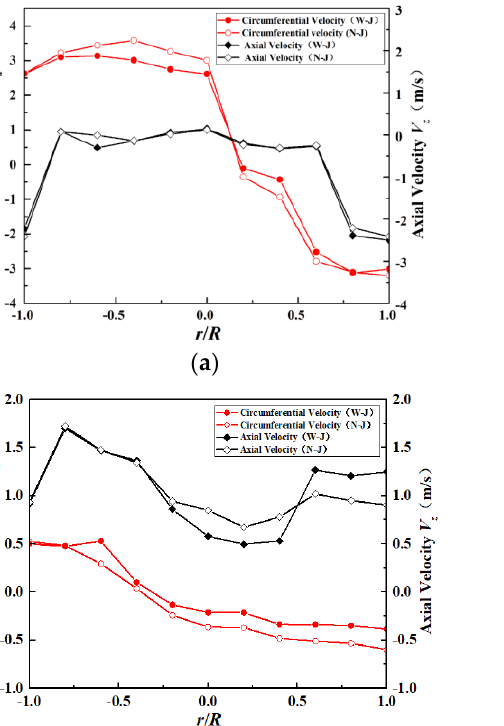
10 of 20 Figure 8. LEPR on section 2 of the draft tube at DPL and PL conditions with or without J-groove. 4.2. Influence of J-Grooves on Velocity Distribution At partial loads, the water no longer flows along the so- called “structural line” of the runner after entering the runner, but rapidly deflects downward the band under the cen- trifugal force [27]. As a result, the rotating speed of the water flow in the runner blade channel increases, and the water flow entering the draft tube inevitably has a certain cir- cumferential speed V u , leading to a vacuum appearing in the center of the conical section. This phenomenon creates the conditions for backflow and recirculation in the draft tube and prepares the final conditions for the generation of vortex rope and vortex pressure fluctuation.